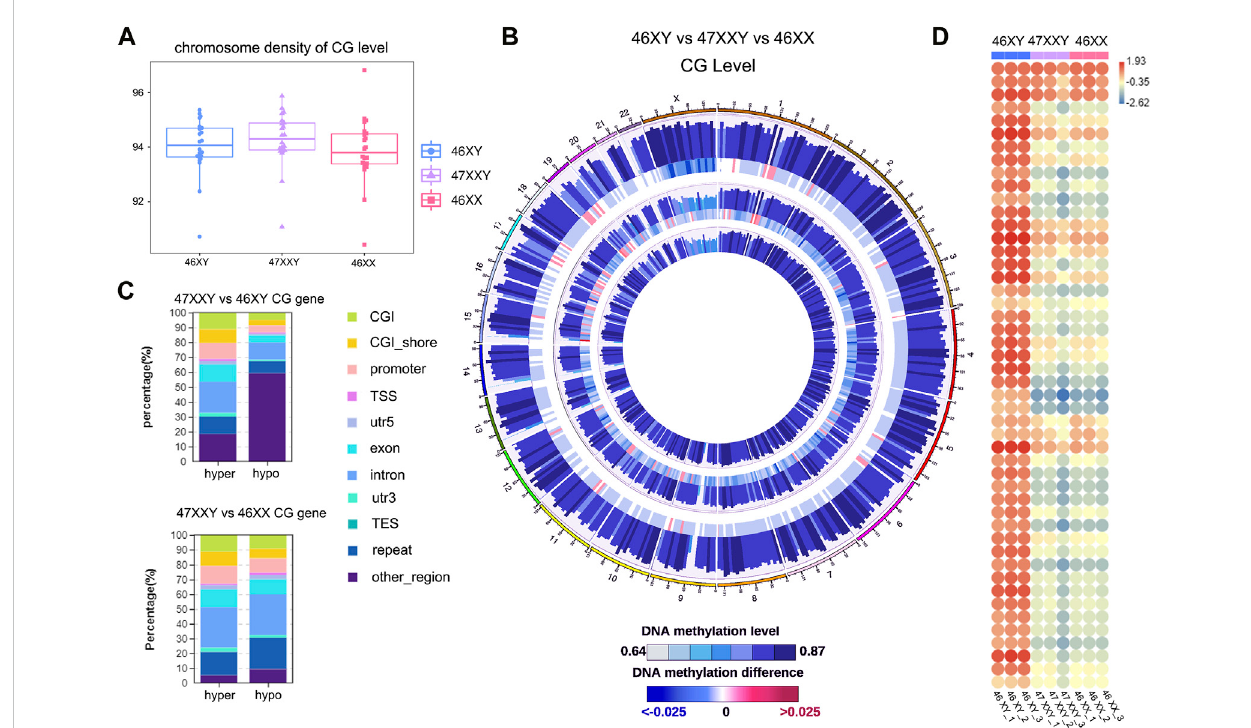
FIGURE 1 The single base methylation level of 47XXY, 46XY and 46XX in CG, CHG and CHH. (A) The beeswarm of chromosome density analyseson of the CG level within the genome-wide scope of 46XY, 47XXY and 46XX. The horizontal axis represents different sample/group names, and the vertical axis represents the methylation level, with 10 KB as a bin. (B) Circos diagram of comparing the methylation levels of different groups. From the outside to the inside, the fi ve circles indicate the methylation level in the 46 XY group, the methylation level difference between the 46XY and 47XXY groups, the methylation level in the 47XXY group, the methylation level difference between the 47XXY and 46XX groups and the methylation level in the 46XX group. The methylation levels in 46XY, 47XXY and 46XX groups, Internal scale: DNA methylation level indicates the level of methylation, while DNA methylationdifferenceindicatesthelevelofmethylationdifferencebetweensamples. (C) TheStackedColumnofhyperandhypoCGgenesinfunctional regions: CGI, CGI_shore, promoter, 5 ’ untranslated region (5 ’ UTR), exon, intron, 3 ’ untranslated region (3 ’ UTR) and repeats region. (D) The heatmap of methylation level in Chr. X in 46XY, 47XXY and 46XX. Each circle represents the everage methylation level in 48 regions of Chr.X. The colors from red, white to blue mean the methylation levels from high, median to low (1.93, − 0.35 to −